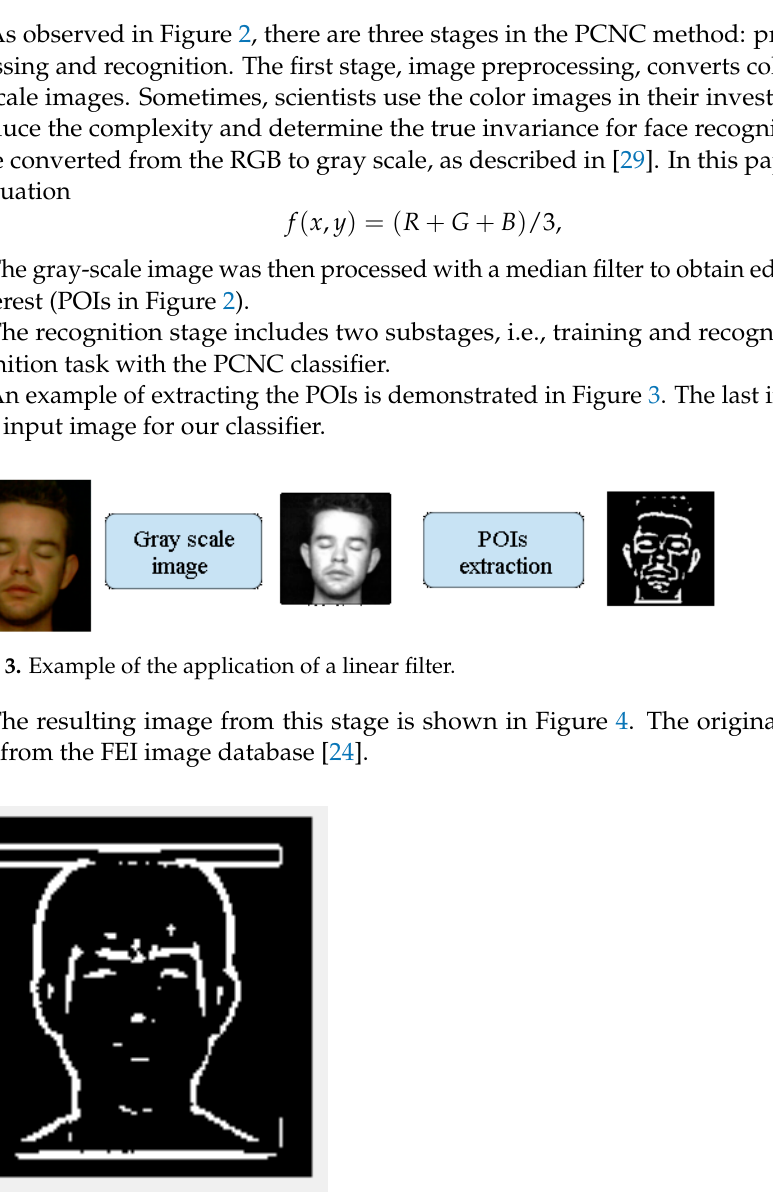
Figure 2. PCNC structure.